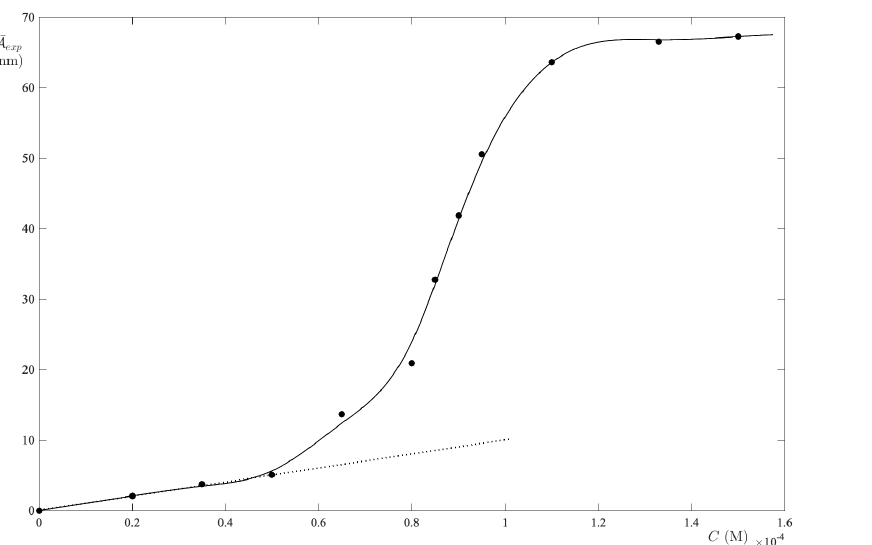
Figure 5. Integral absorbance vs. FS concentration in ACN. The limiting slope determines the absorption coefficient of the monomer form. The curve is a guide for the